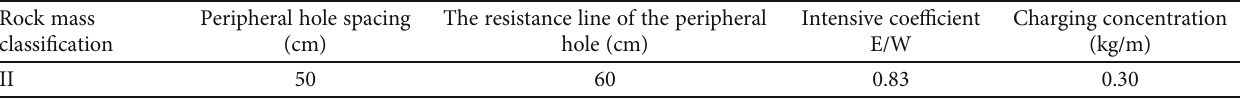
Table 2: Smooth blasting parameters.